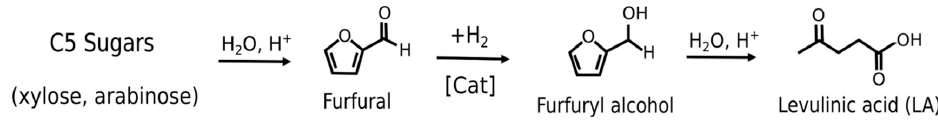
Figure 4. C 5 path to give levulinic acid.